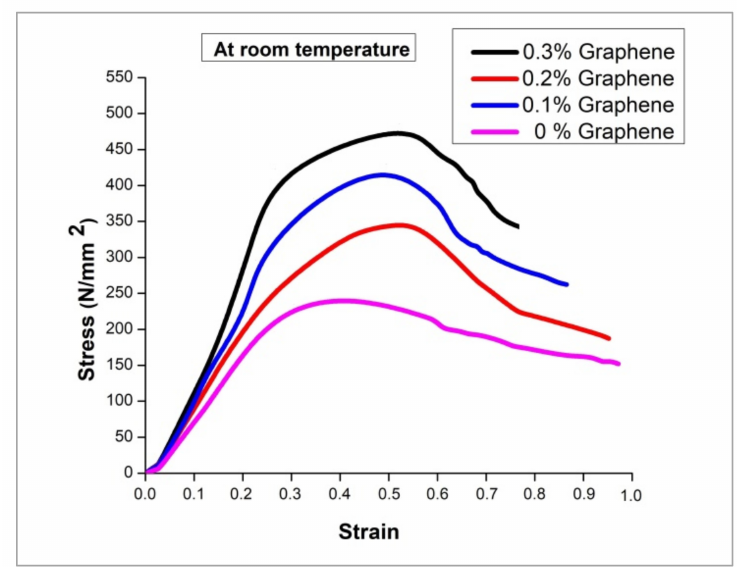
Figure 9. Stress-strain plot at room